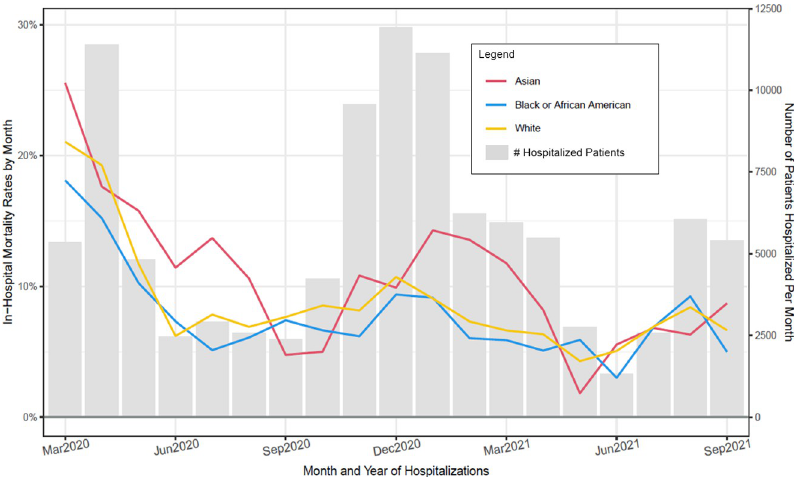
three-month period (Period 1: February-April 2020) and within the last three-month period (Period 2: July-September 2021); 2) observed change within each patent variable category